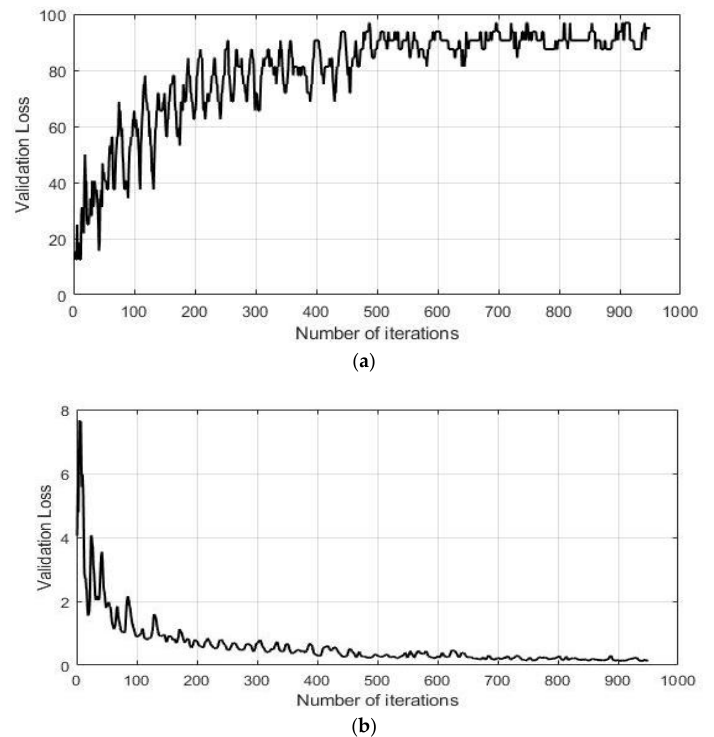
Figure 17. Learning trend of GoogLeNet for the IR-UWB radar with 1920 epochs: ( a ) validation accuracy in percentage and ( b ) validation loss.